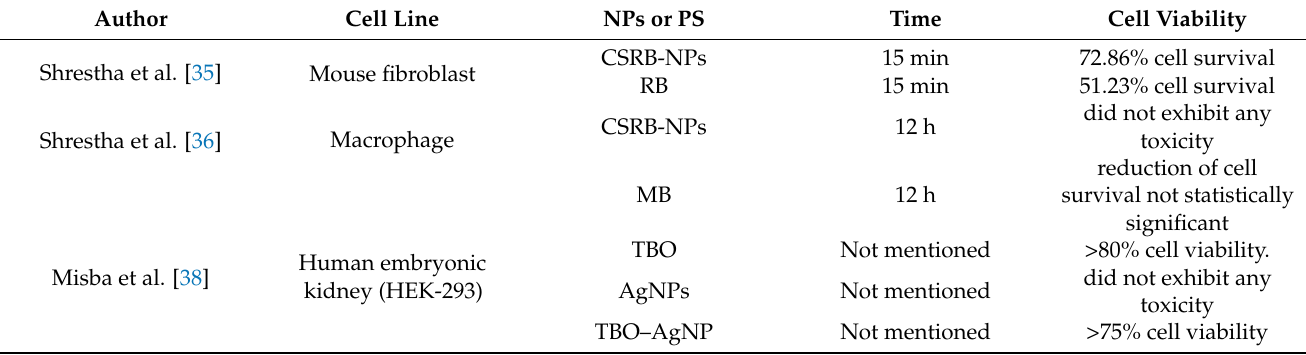
Table 4. Toxicity in adjacent